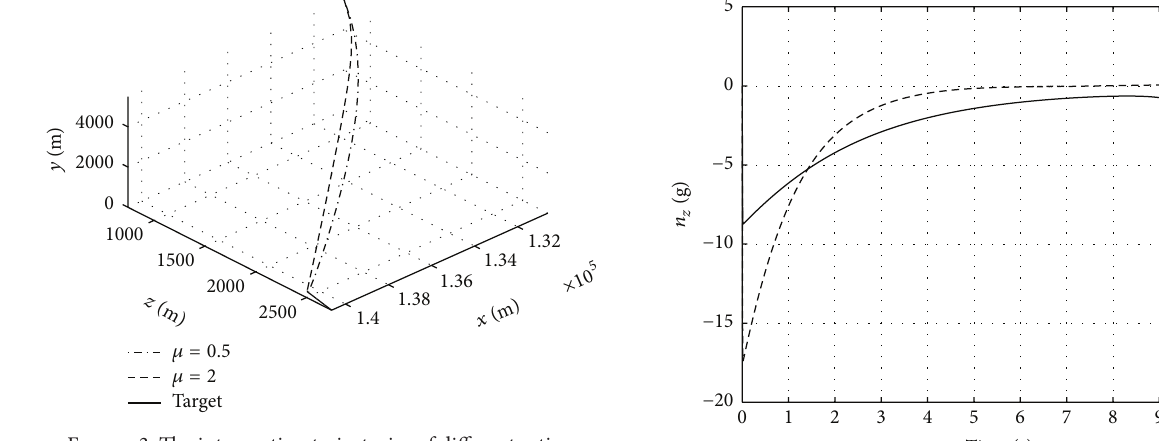
Figure 3: The interception trajectories of different ratios.